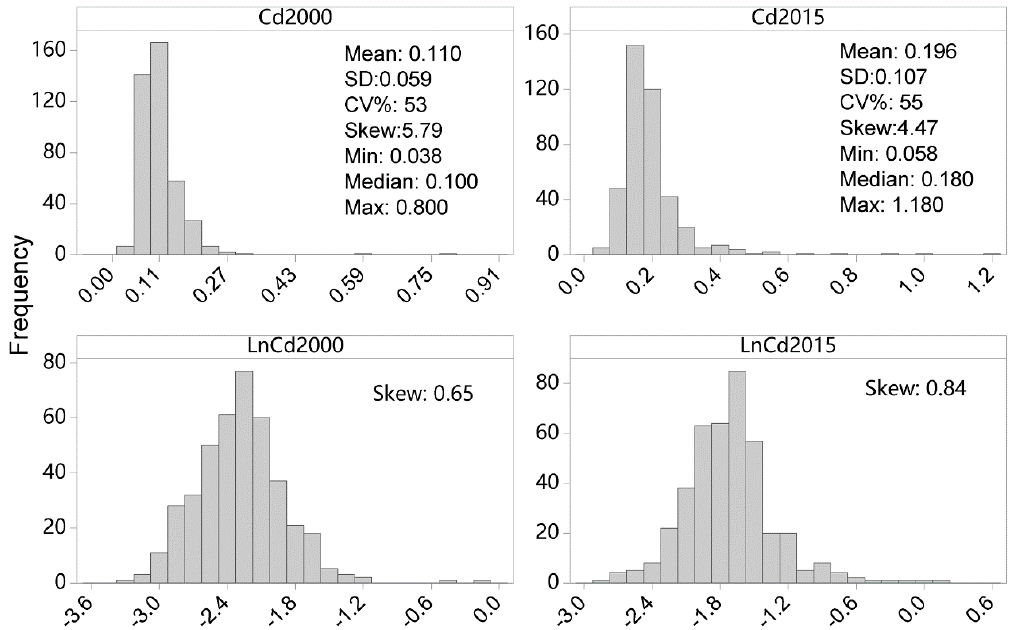
Figure 2. Histograms and summary statistics of topsoil Cd concentrations (mg/kg). Min, Max, SD, and CV represent minimum, maximum, standard deviation, and coefficient of variation, respectively.